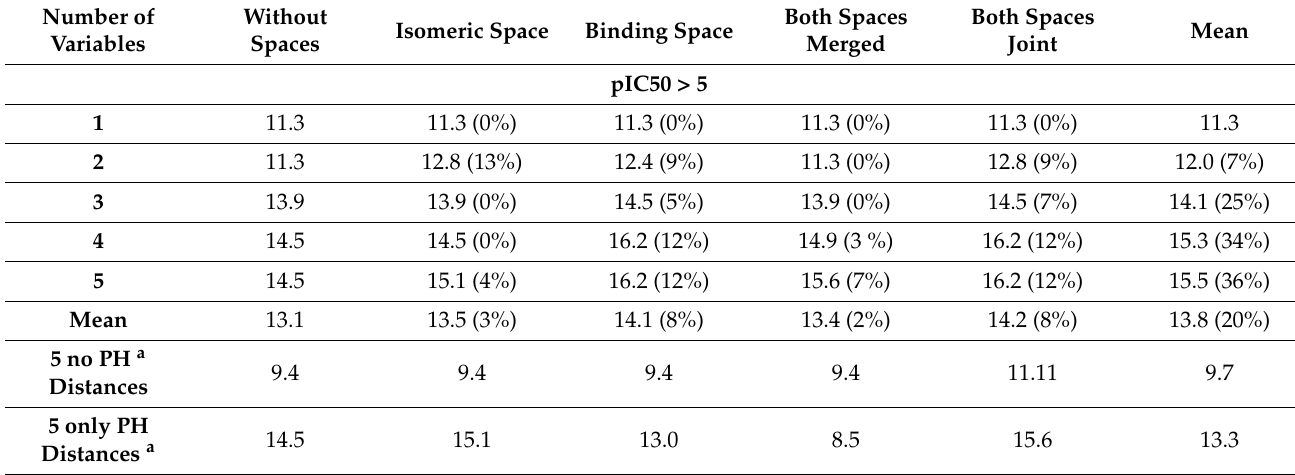
Table 3. Best EF1% values reached by the various consensus models developed using the LiGen results plus the relative average values and the corresponding performance enhancements in percentage values. As described under Methods, the consensus equations were generated by linearly combining from two to five docking scores. The EF1% values referring to one variable correspond to the performances of single scoring